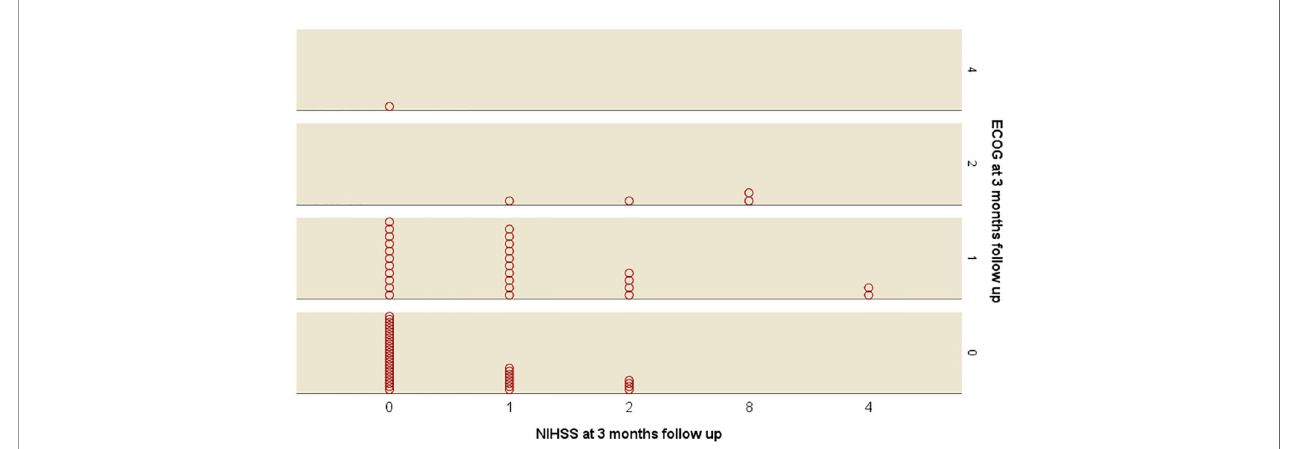
FIGURE 1 | Histogram comparing Eastern Oncology Group (ECOG) score and National institute of health score (NIHSS).